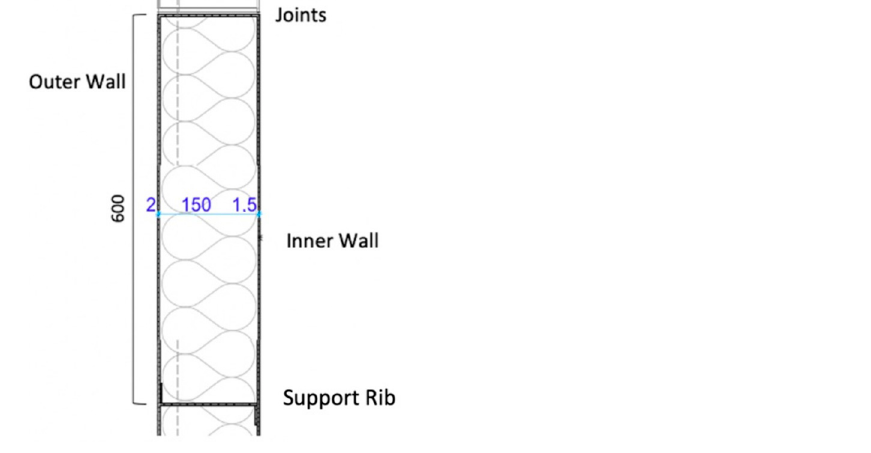
Figure 3. Vertical fiberglass panels used in the vertical exterior walls of the fiberglass house.